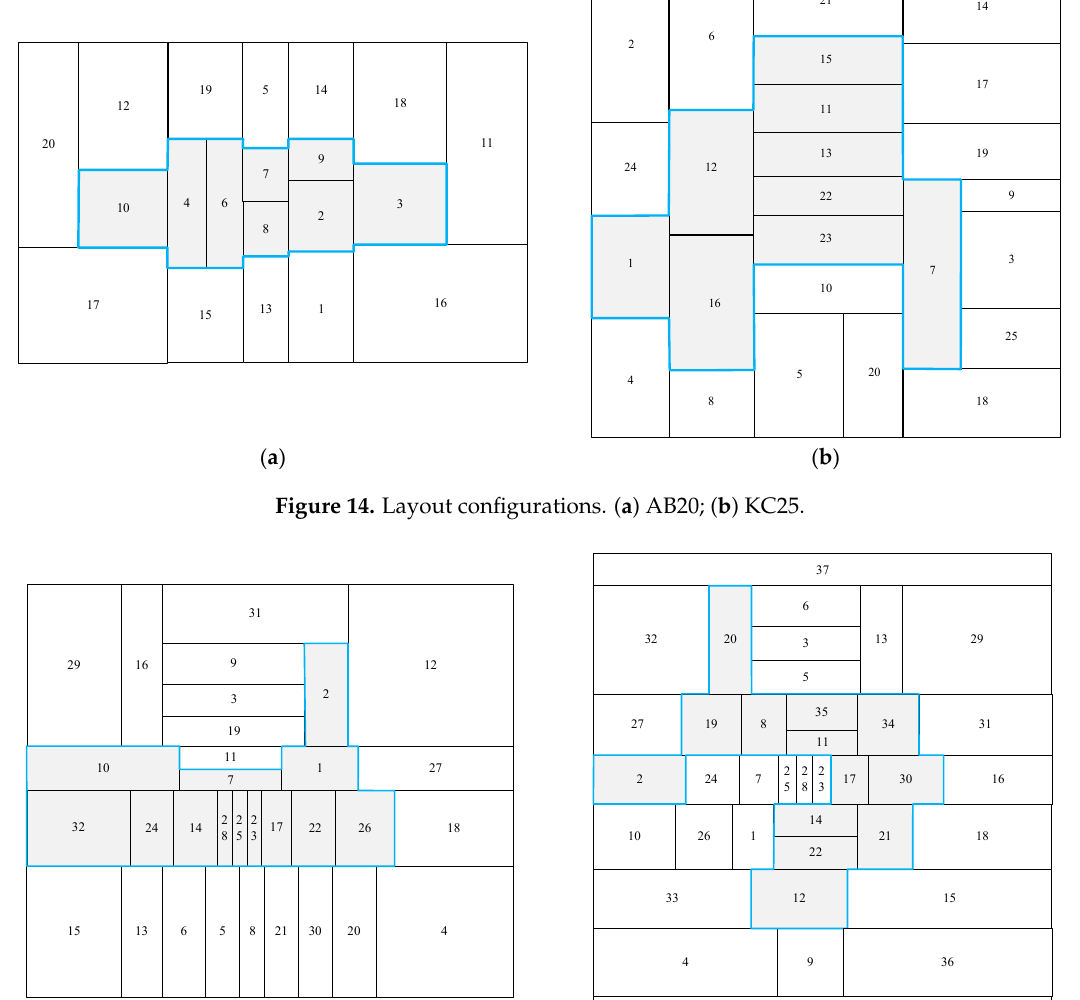
Figure 13. Layout configurations. ( a ) vC10s; ( b ) vC10a; ( c ) KC15.